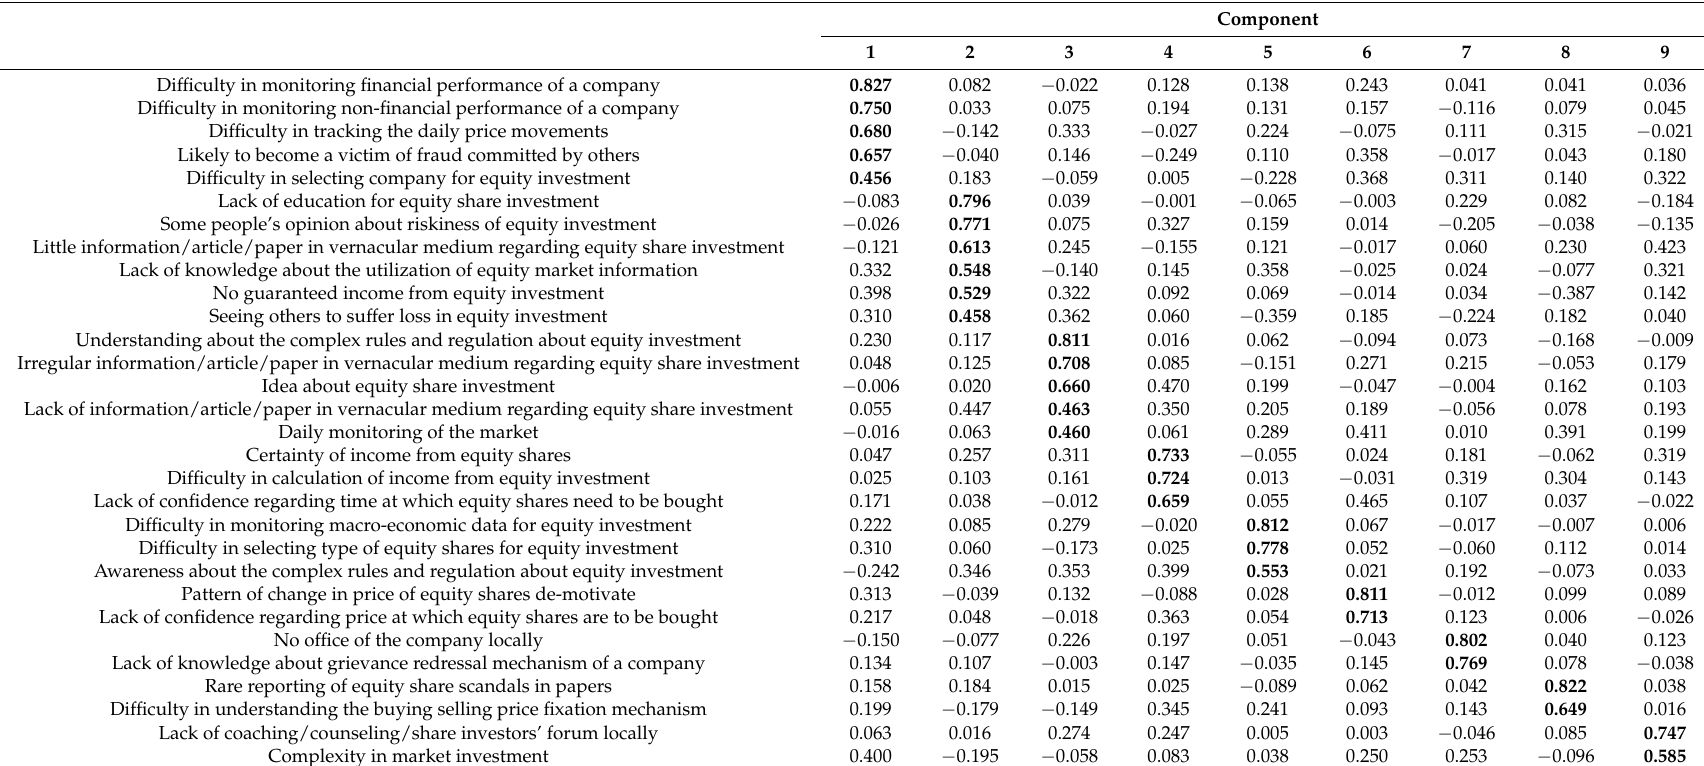
Table 9. Rotated Component